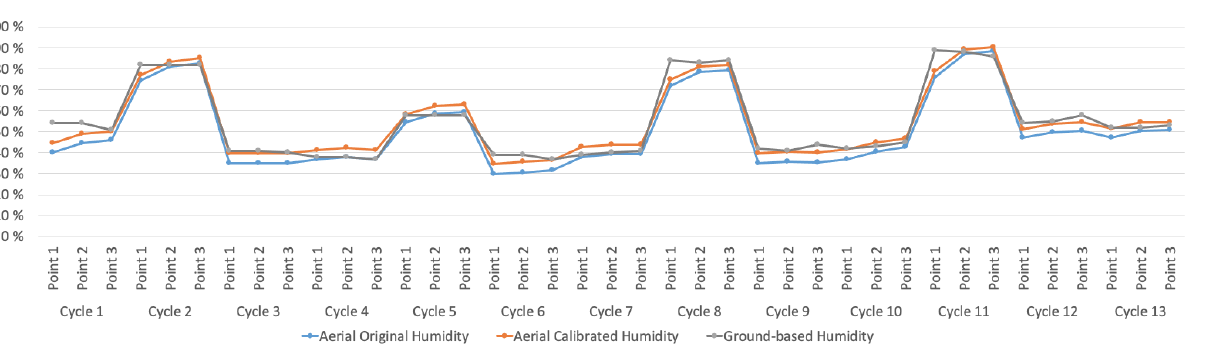
Figure 14. Original and calibrated aerial humidity data compared with ground-based